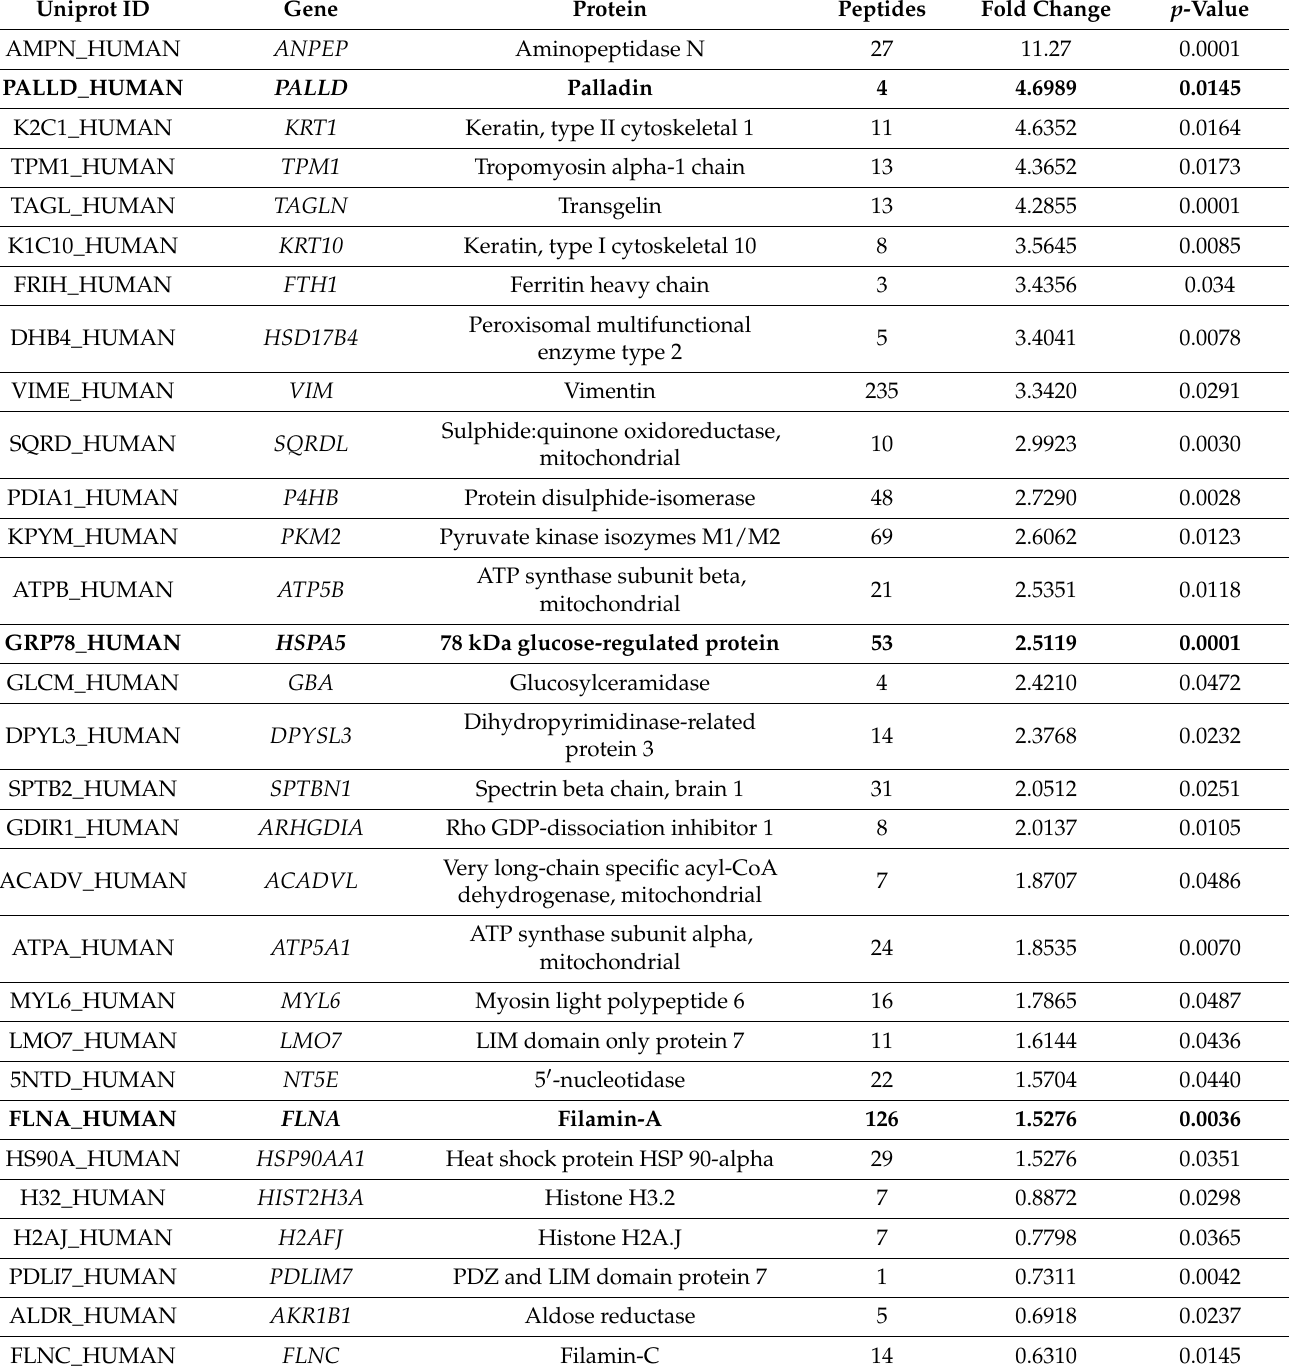
Table 2. Differentially expressed proteins identified in MSC isolated from subchondral bone, compared to that from cartilage. Uniprot ID Gene Protein Peptides Fold